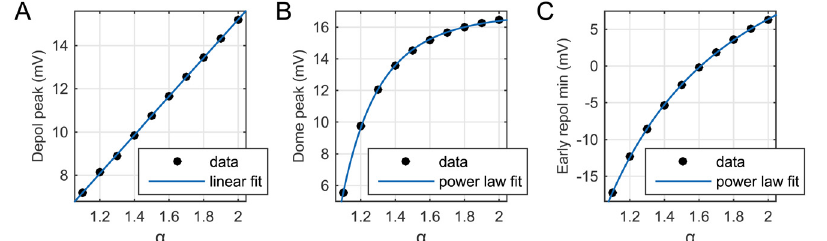
Fig 5. Curve fitting of three data sets obtained from the AP solution profile at the node P 2 for ten different values of α 2 (1, 2]. (A) AP depolarization peak height, (B) dome peak height, (C) early repolarization minimum.